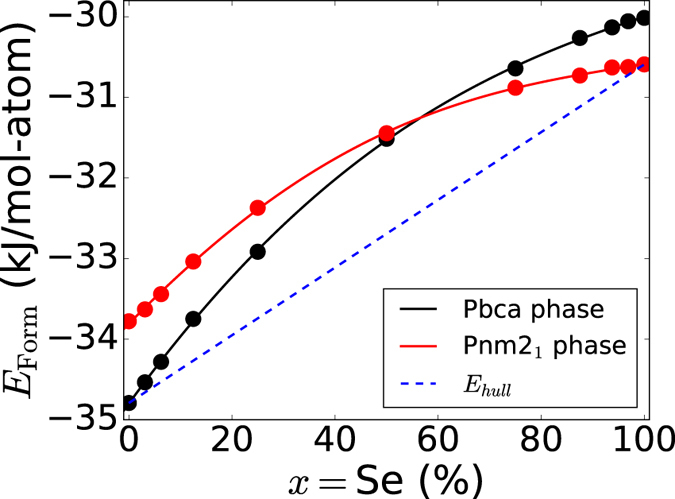
Energy of formation(in kJ/mol-atom) of CoSbS1−xSex paracostibite(Pbca) and costibite(Pnm21) as a function of the alloying concentration, x.